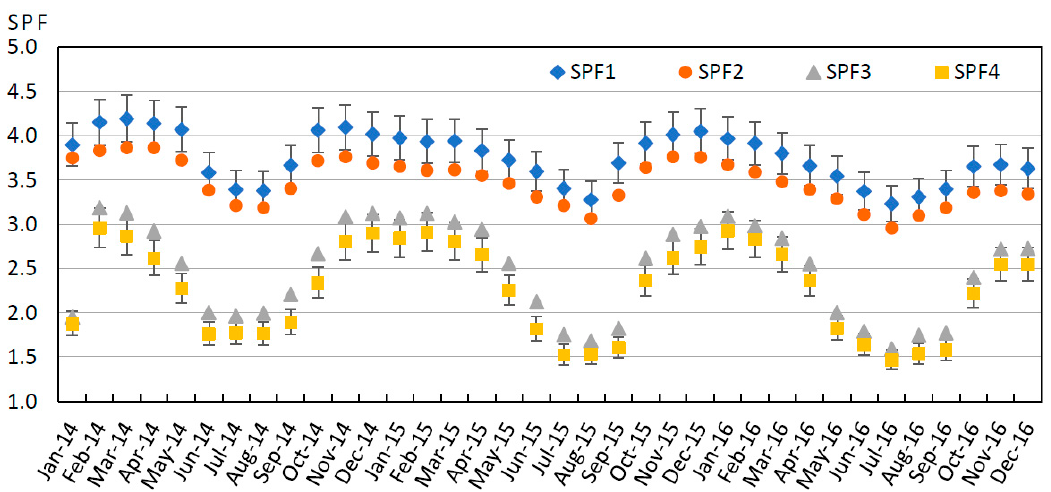
Figure 18. Monthly SPF values based on SEPEMO boundaries.